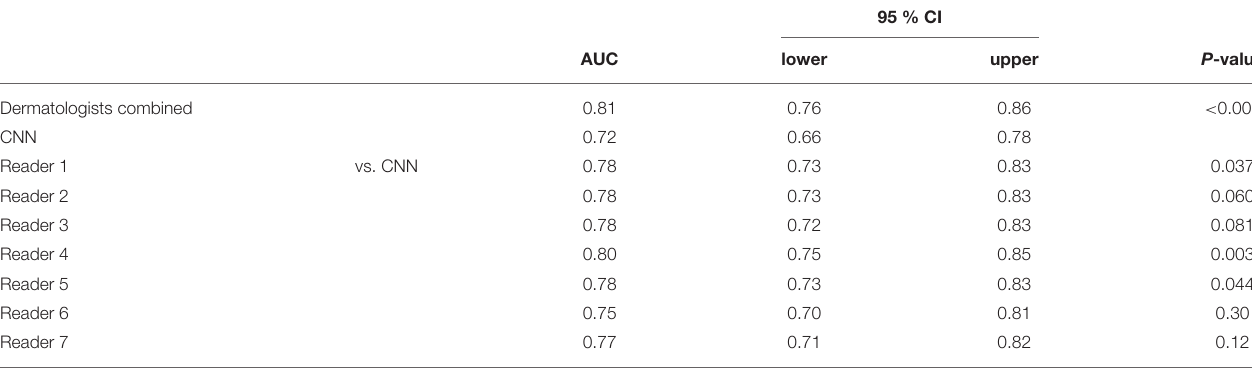
TABLE 3 | Comparison of AUC achieved by the CNN, the dermatologists combined, and each dermatologist